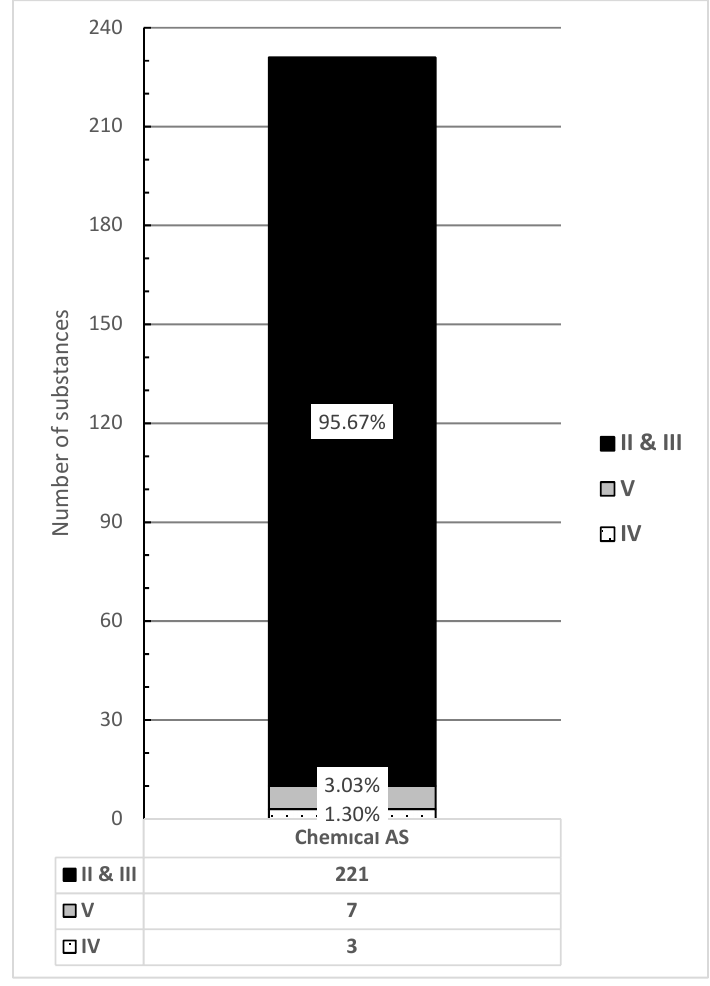
Figure 3. Maximum residue limits of agrochemicals.